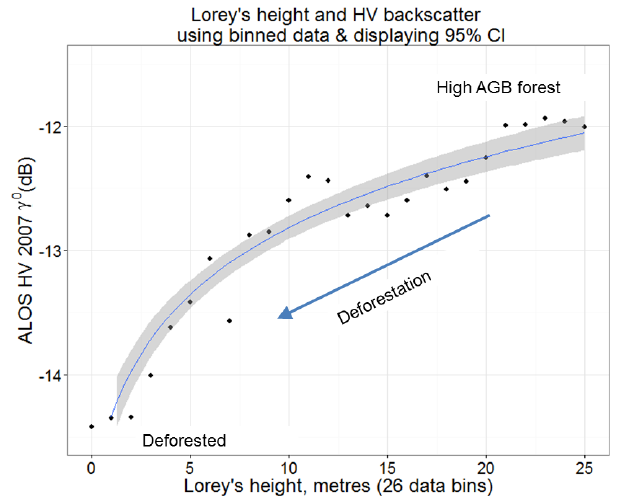
Figure 3. Non-linear relationship between HV backscatter and Lorey’s height. This diagram demonstrates the logic behind the se- lection of the 10m height threshold for the definition of deforesta- tion. Values in the upper right of the graph have both high Lorey’s height values and high HV backscatter values, which we interpret as being natural high-biomass forest. In the bottom left of the image are data points which have low AGB and low Lorey’s height values, which we interpret as being degraded forest through to cleared for- est. If the value of a pixel moves from the upper right of the plot to the lower left, such that the height reduction is ≥ 10m during 1 year, we interpret this as a deforestation event. This process is rep- resented by the arrow pointing downwards to the